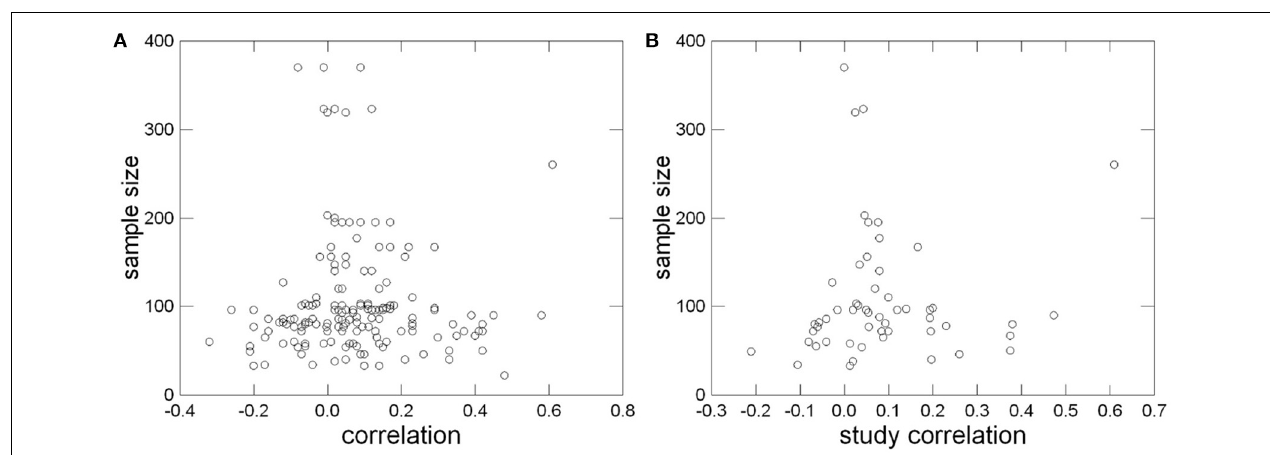
FIGURE 4 | “Funnel-Plot” of single correlations (A) and of study correlations corrected for sampling error (B) for identification of a publication